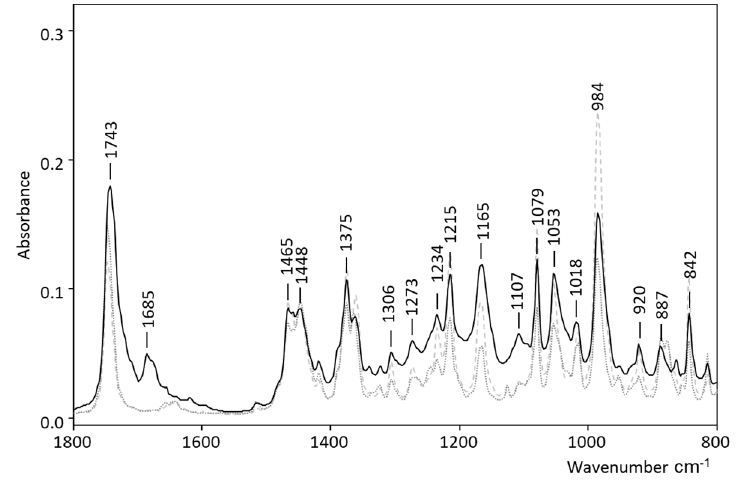
Figure4. SuperimposedATR-FTIRspectraofconcentratedlavenderessentialoilsample(solidblackline) Figure 4. Superimposed ATR-FTIR spectra of concentrated lavender essential oil sample (solid black and commercial-grade lavender oil line) and commercial-grade lavender oil samples.